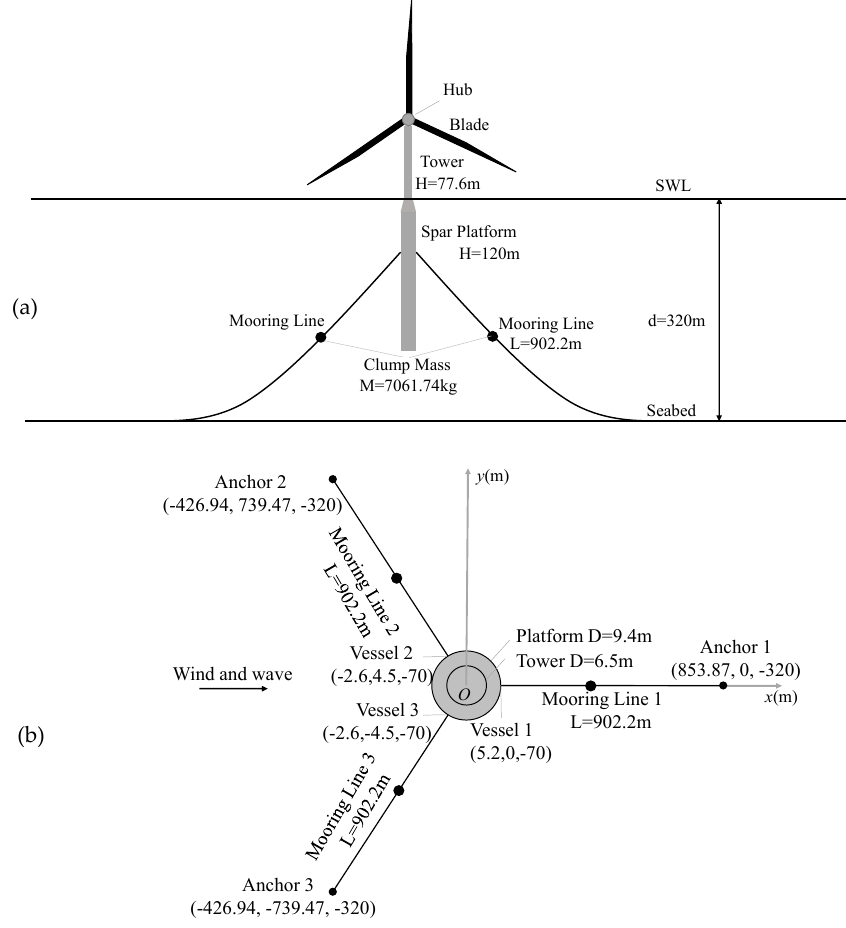
Figure 2. Structure of the new model: ( a ) front view; ( b ) top view.